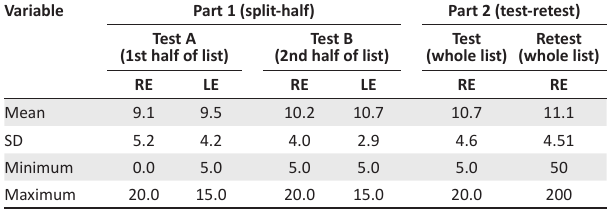
TABLE 1: Speech reception threshold measurements for parts one (internal consistency) and two (external consistency) of the study. Variable Part 1 (split-half)